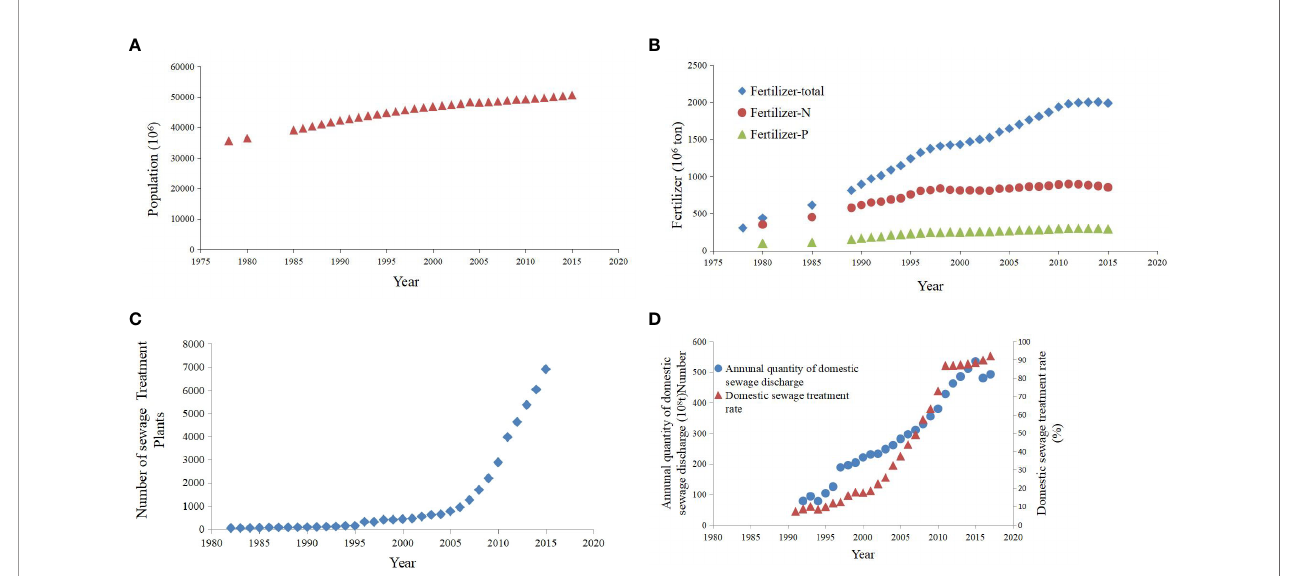
FIGURE 5 | Long-term changes in population (A) and fertilizer use (B) in the Changjiang River Basin; Long term variation of number of sewage treatment plants (C) , annual quantity of domestic sewage discharge (D) , domestic sewage treatment rate (D) in China.